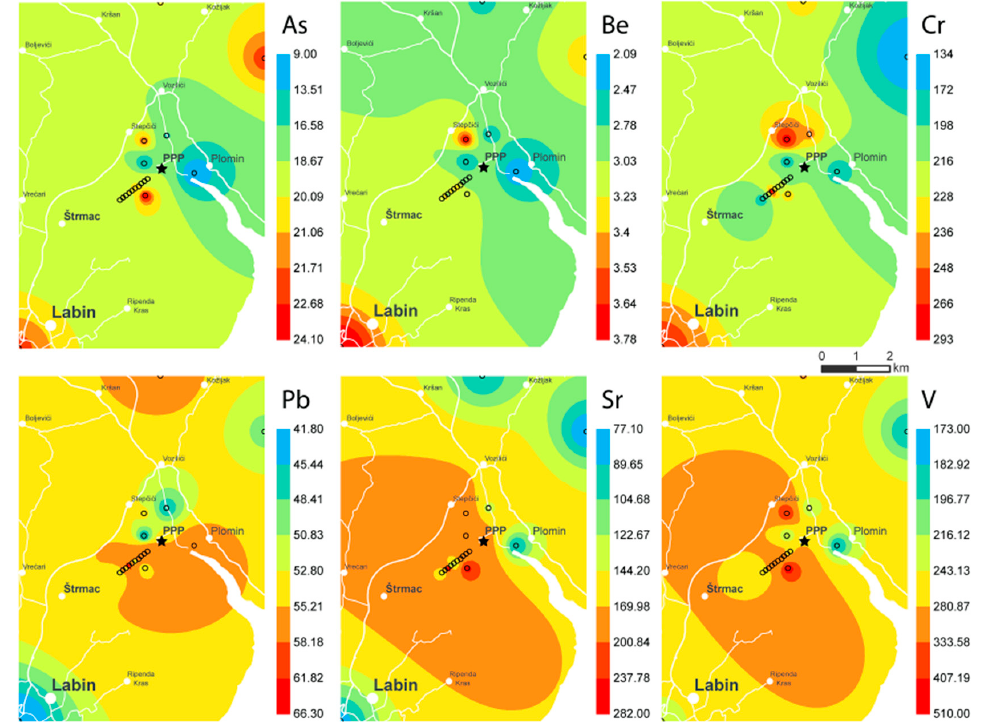
Figure 3. Soil arsenic and trace metal contour maps.